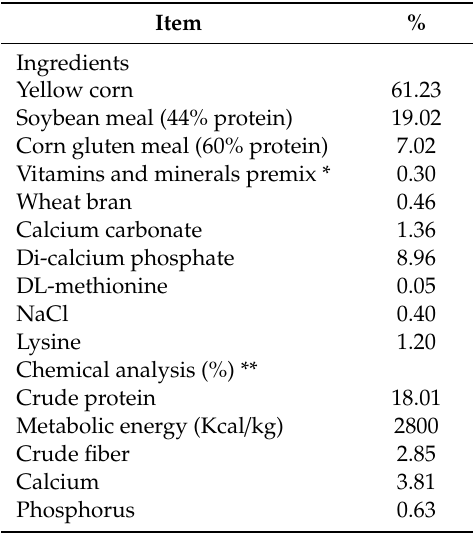
Table 1. Ingredients and calculated analysis of layer basal